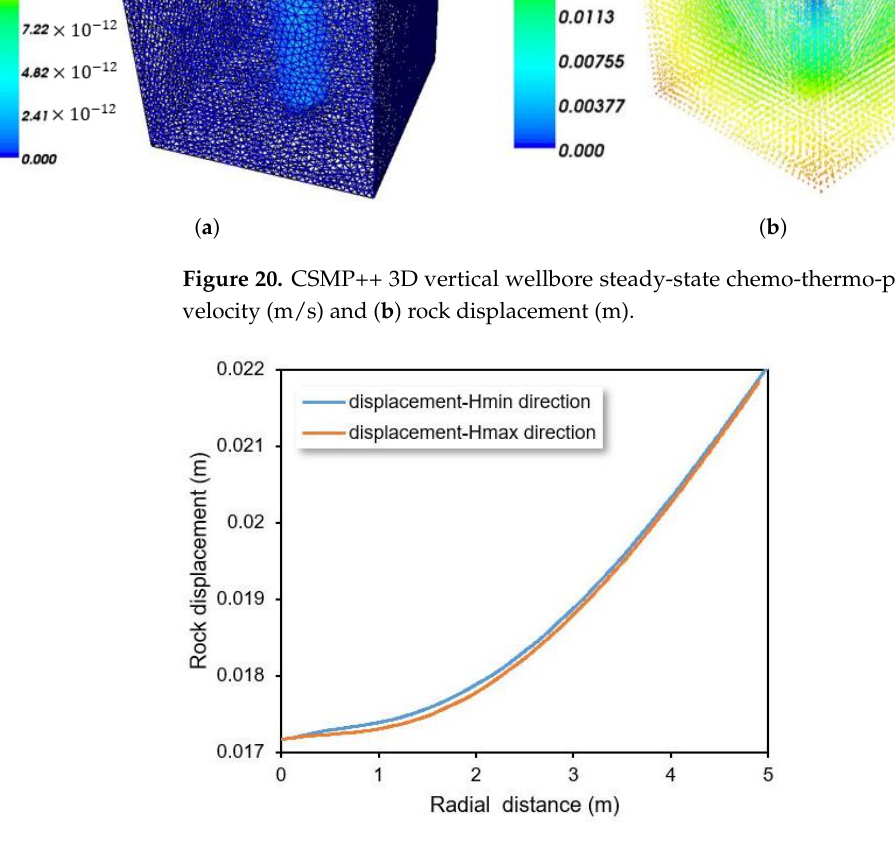
Figure 21. CSMP++ graphical plot of the rock displacement in the minimum and maximum horizontal in situ stress directions for a 3D chemo-thermo-poroelasticity steady-state simulation for Pw-20